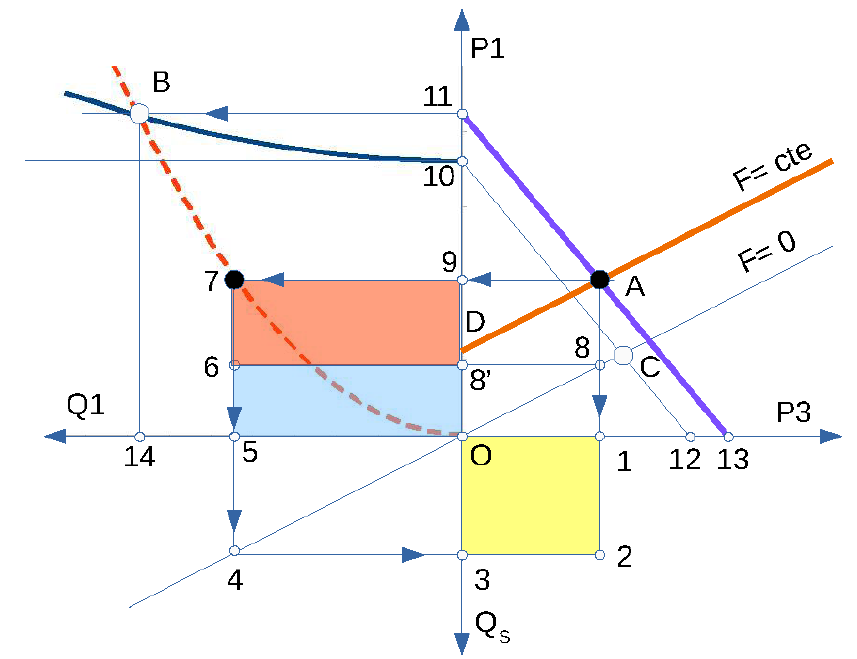
Figure 8. Scheme to display the described graphics approach. N LHV = A Blue + A Red = A O 579 , N S = A Yellow = A Blue = A O 123 = A 056 8′ and N M = A Red = A 679 8′ .